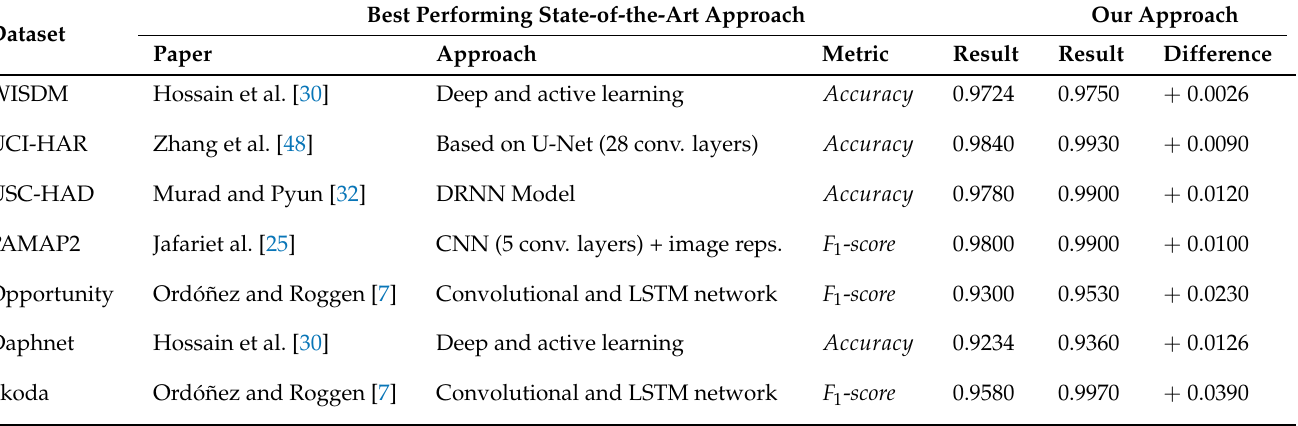
Table 9. Our approach vs. best approaches in the